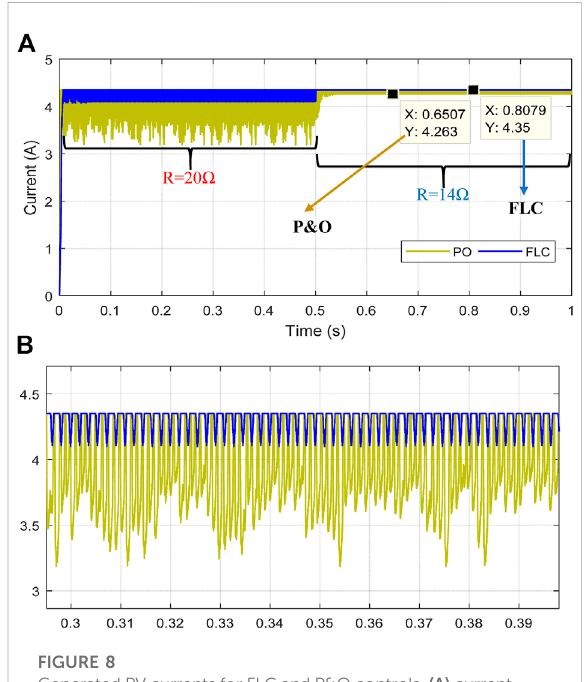
FIGURE 8 Generated PV currents for FLC and P&O controls. (A) current response. (B) Zoom on the current response.